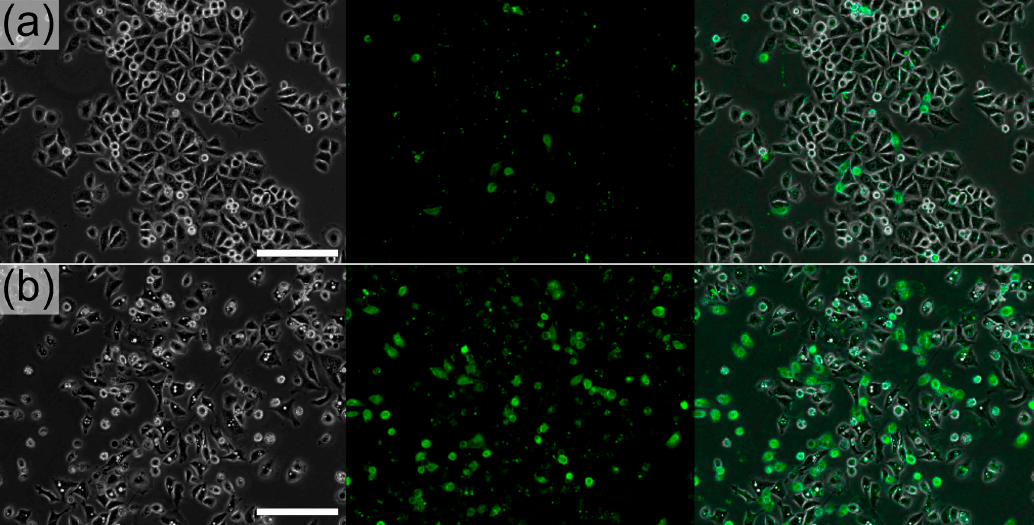
Figure 4. Annexin V staining demonstrates the apoptotic effect of bacterially delivered violacein at a MOI of 25 at 10 h post-infection. ( a ) 7% of HeLa S3 cells treated with a control invasive DH10B showed annexin V staining (right panel); ( b ) 33% of HeLa S3 cells treated with bacterially delivered violacein showed annexin V staining. Scale bars represent 100 μ m.